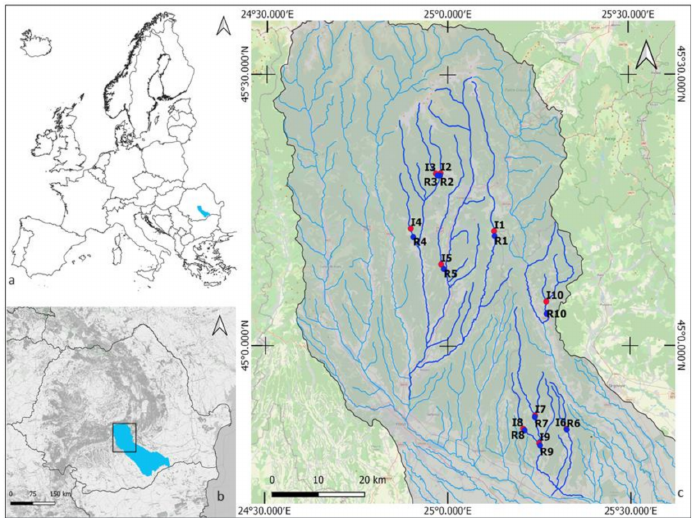
Figure 1. The study site locations in the Arges marked in blue, and the unforested buffer sites (I1–I10) in